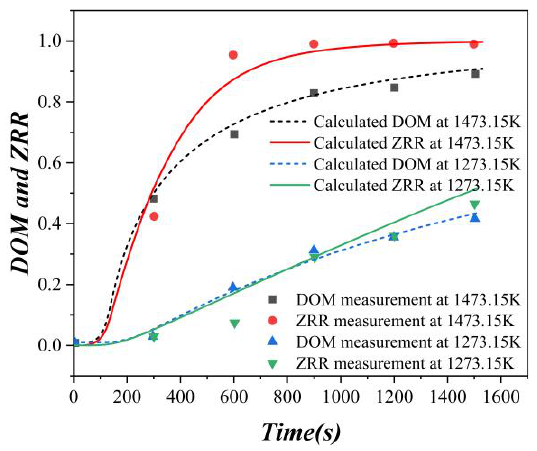
Figure 5. Comparison of the degree of metallization (DOM) and zinc removal rate (ZRR) calculated and experimental results at a reduction temperature of 1273.15 K and 1473.15 K over time.